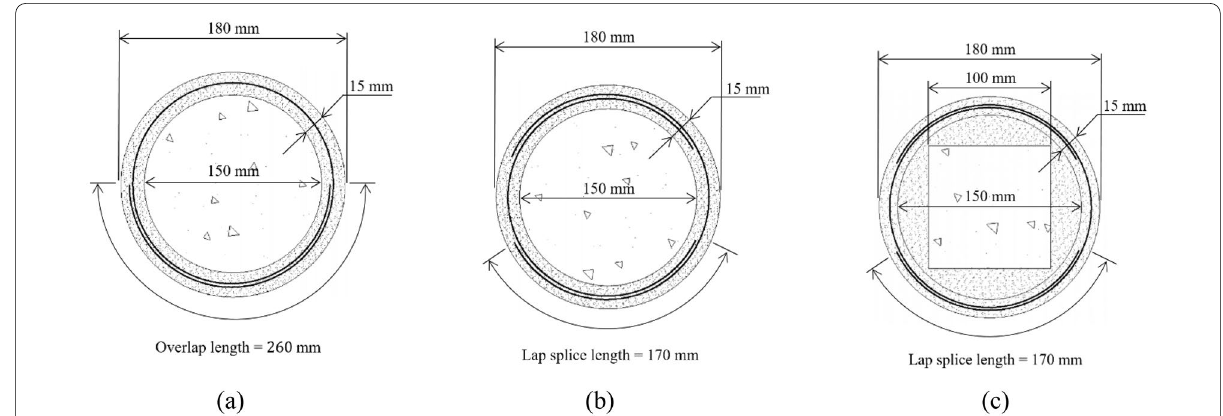
Fig. 5 Confinement test: cross sections of circular specimens. a Type-1, b Type-2, c